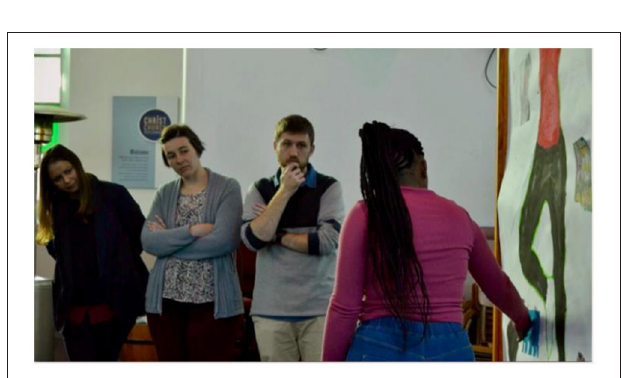
FIGURE 4 | Researchers from the Water Resource Laboratory listen as an Enkanini community member presents her body map as part of knowledge exchange